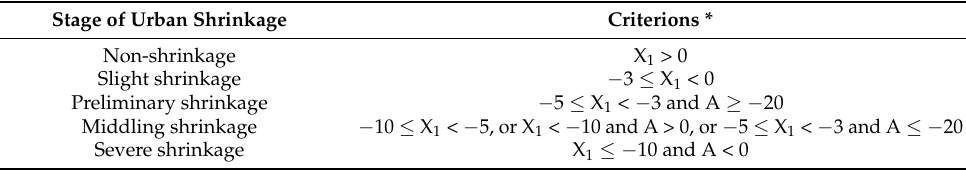
Table 2. Stages of urban shrinkage and the classification